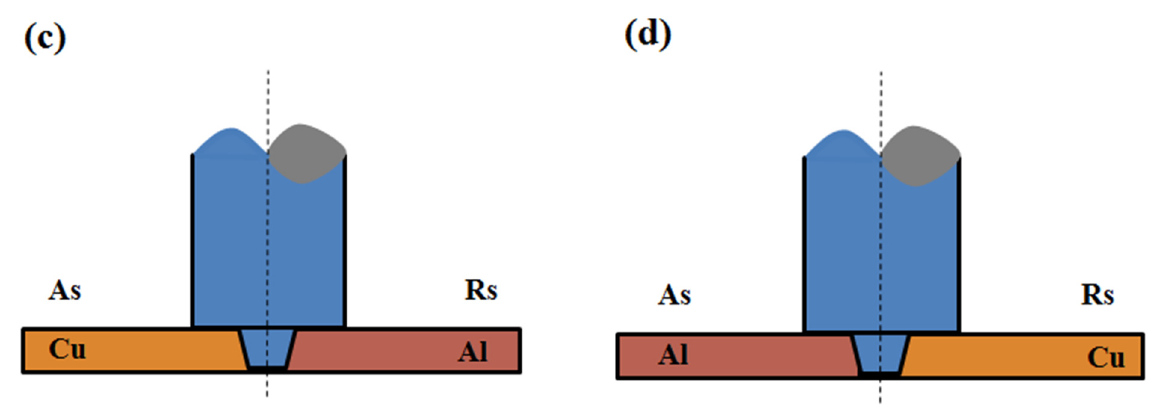
Figure 6. Material placement position of ( a ) Cu on the top; ( b ) Al on the top; ( c ) Cu on the AS; ( d ) Al on the AS.